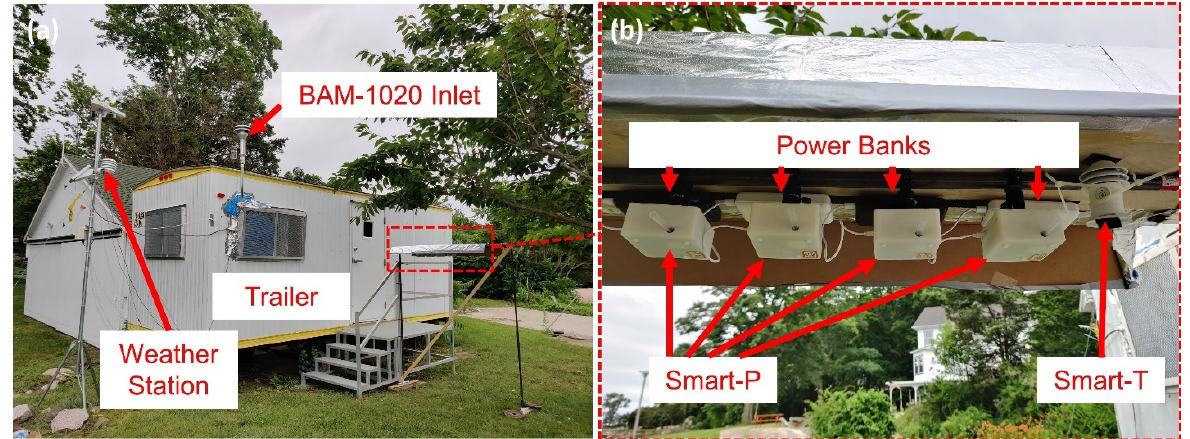
Figure 4. Collocation at Yale Costal Field Station (YCFS): ( a ) YCFS site; ( b ) Smart-P installation.